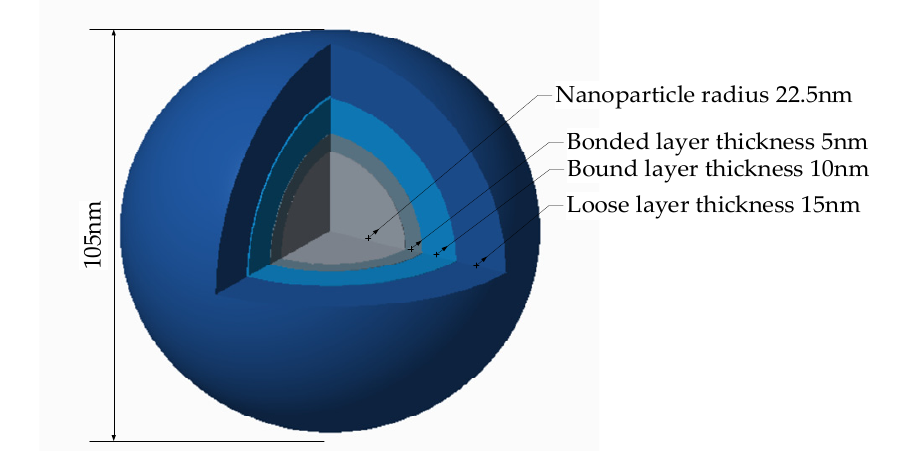
Figure 7. Multi-shell model of SiO 2 nanoparticles. To study the effect of nano-interfaces on carrier migration, randomly distributed multishell SiO 2 nanoparticles were added to the epoxy resin as charge traps to simulate the process of carrier capture by charge traps. Jiasheng et al. derived the energy levels and densities of deep and shallow traps in the epoxy resin-based SiO 2 nano dielectric based on the Simmons theory of surface potential decay, according to which the energy levels and densities of deep and shallow traps were set [22,23] The trap depths of deep and shallow traps are 0.99 eV and 0.925 eV, and the densities of deep and shallow traps are 2.8 × 10 18 and 2.2 × 10 18 eV − 1 · m − 3 . The bonding layer is set to a deep trap and 1.11 eV above the trap depth of the substrate itself, and the loose layer is set to a shallow trap of 0.93 eV, stopping the motion of the particles when the electrons pass through the trap range if the energy is below the trap depth. The trap will capture the carriers injected into the substrate material, and the capture chance is usually determined according to the capture cross-section, which is larger for the shallow trap than the deep trap, so the shallow and deep trap cross sections are set to 10 − 14 m 2 and 10 − 16 m 2 [24]. As there is a certain law for the distribution of nanoparticles in the medium, the distance between two adjacent nanoparticles at a certain concentration in the ideal case of no agglomeration is [25]: